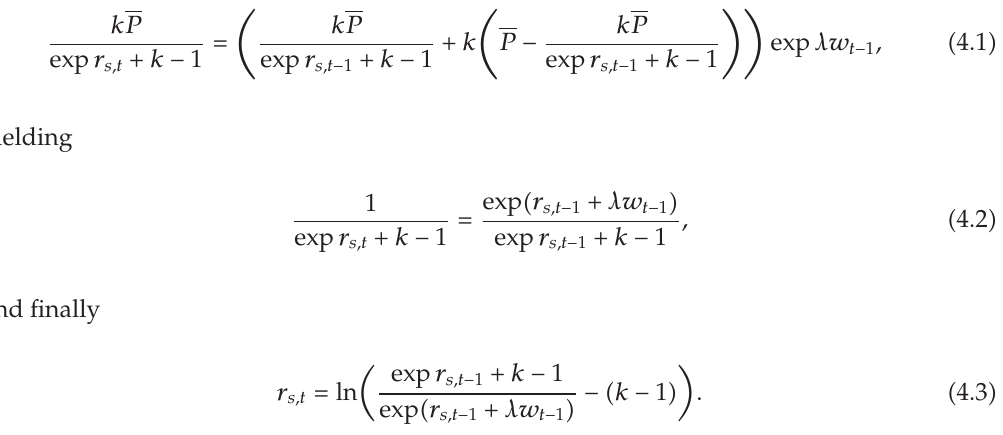
(cid:3) w (cid:6) with r t − 1 , r s t